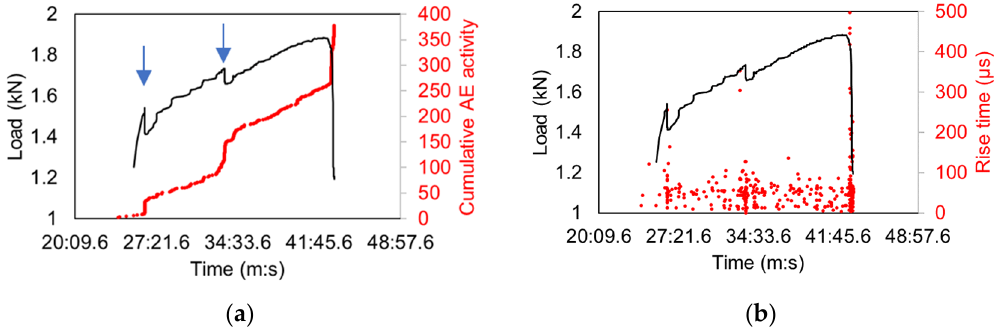
Figure 7. Load history with ( a ) cumulative hits and ( b ) rise times from a curved TRC plate 300 mm wide.